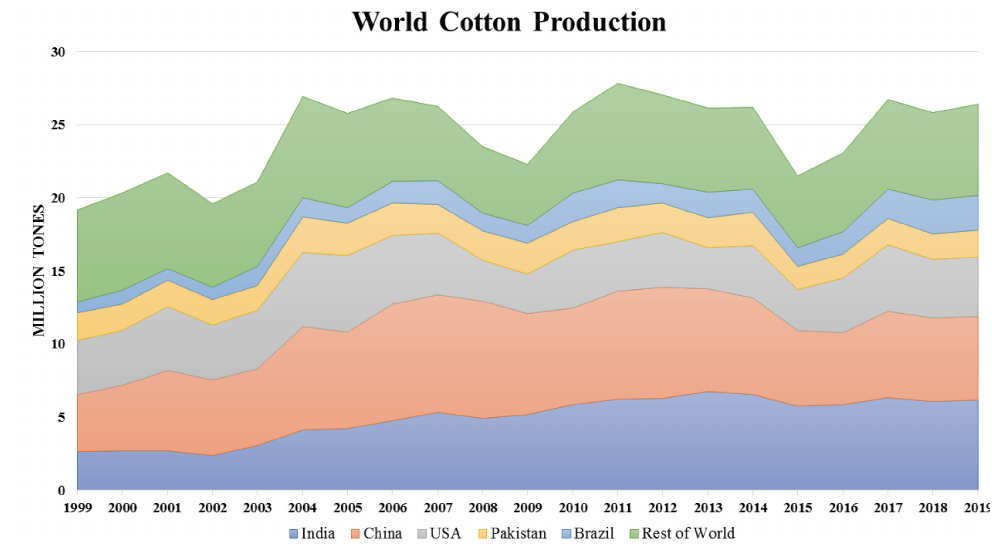
Figure 1. World cotton production status in last two decades. The data is retrieved from OECD / FAO (2019), “OECD-FAO Agricultural Outlook”, OECD Agriculture statistics database.